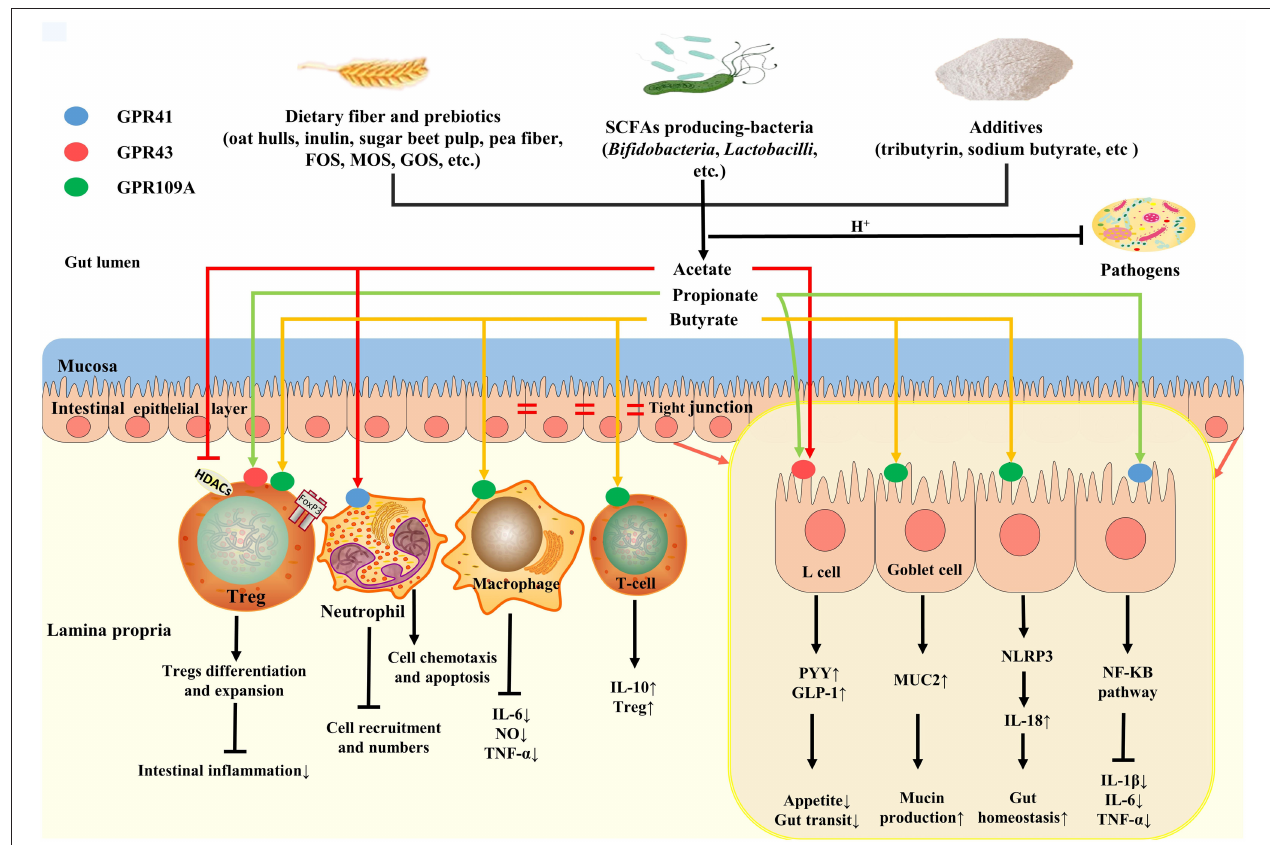
FIGURE 2 | Roles and potential benefits of SCFAs on gut health of poultry. Dietary fibers, SCFAs-producing bacteria and additives collectively regulate SCFAs production in gut. SCFAs (mainly acetate) can reduce luminal pH, thus inhibiting pathogens colonization. Butyrate, as the major energy source, not only provide energy for epithelial cells metabolism, but also promote mucin production by binding to GPR109A in goblet cell, thus improving gut mucosa barrier. In addition, butyrate can play an anti-inflammatory and immunoregulatory effect by GPRs or HDAC inhibition, which maintains gut homeostasis. Luminal acetate or propionate sensed by GPR41 and GPR43 sited on L cells releases PYY and GLP-1, affecting appetite and gut